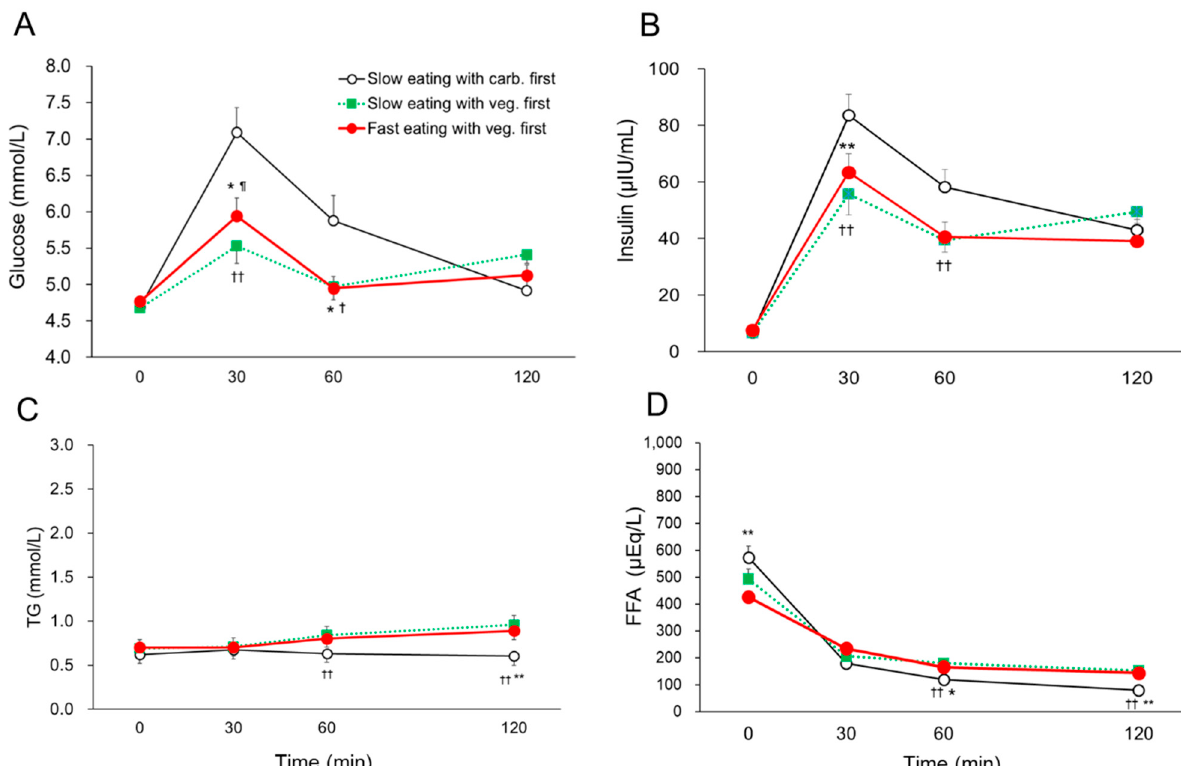
Figure 3. The postprandial blood glucose ( A ), insulin ( B ), TG ( C ), and FFA ( D ) concentrations at 0, 30, 60, and 120 min in the three different study days on which identical meals were consumed with different eating speed and food order in young, healthy women ( n = 18). Data are mean ± SEM. TG; triglyceride, FFA; free fatty acid. veg.; vegetables, carb.; carbohydrate. Slow eating with carb. first vs. Fast eating with veg. first; p < 0.05 *, p < 0.01 **. Slow eating with carb. first vs. Slow eating with veg. first; p < 0.05 † , p < 0.01 †† . Slow eating with veg. first vs. Fast eating with veg. first; p < 0.05 ¶ .